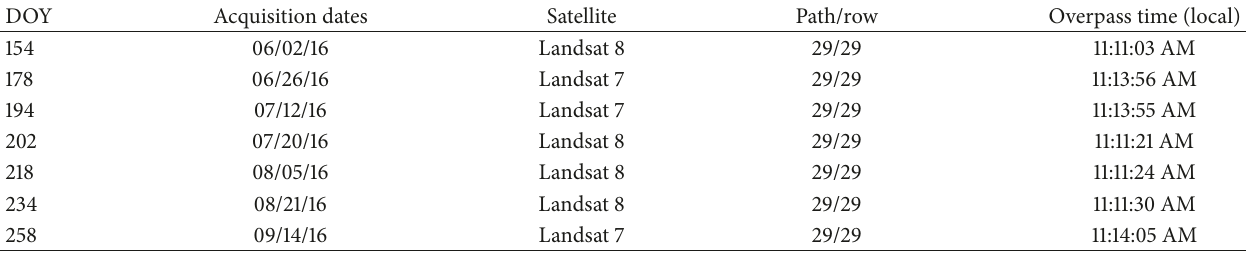
Table 1: Day of year (DOY), selected acquisition dates, Landsat satellite, path/row, and overpass time during the 2016 corn growing season at standard time, used for ET estimations. a